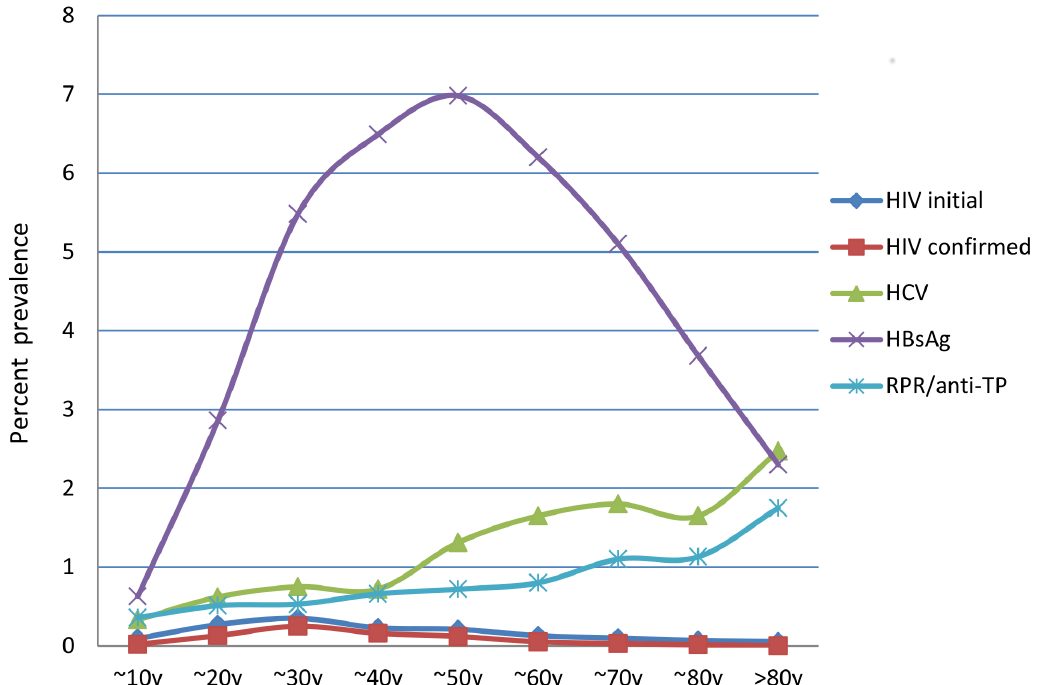
Fig 1. Seroprevalences of HBV, HCV, HIV, and TP According to Age. HBV, hepatitis B virus; HCV, hepatitis C virus; HIV, human immunodeficiency virus; TP, Treponema pallidum ; RPR, rapid plasma regain test.